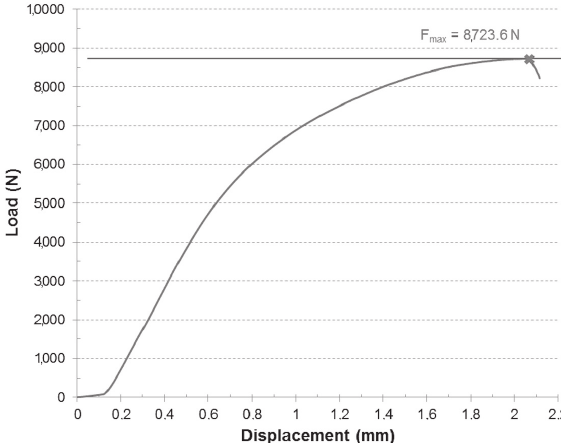
Figure 5- Exemplarily chosen load-displacement curve of a test